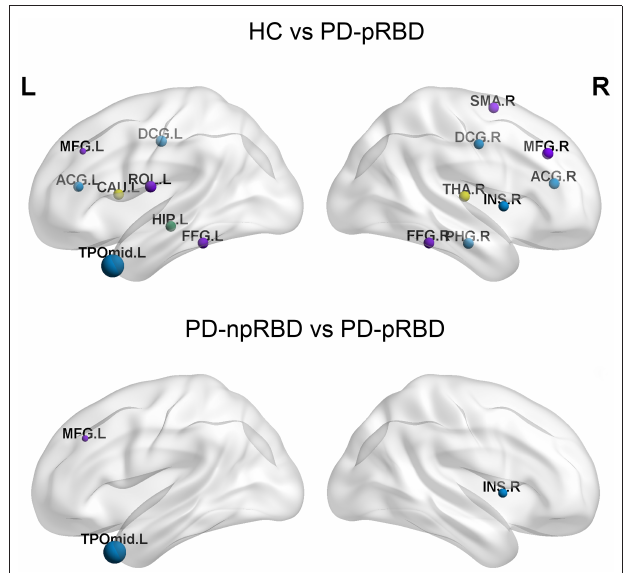
FIGURE 2 | The distribution of brain regions with significant differences in nodal efficiency in HC, PD-npRBD and PD-pRBD groups. The size of the node reflects the value of the nodal efficiency. Different colors indicate a functional classification of brain regions: red, primary, purple, association, blue, paralimbic, green -limbic; yellow, subcortical. The abbreviations of the 90 brain regions are given in Supplementary Materials (Online Resource). L, left hemisphere; R, right